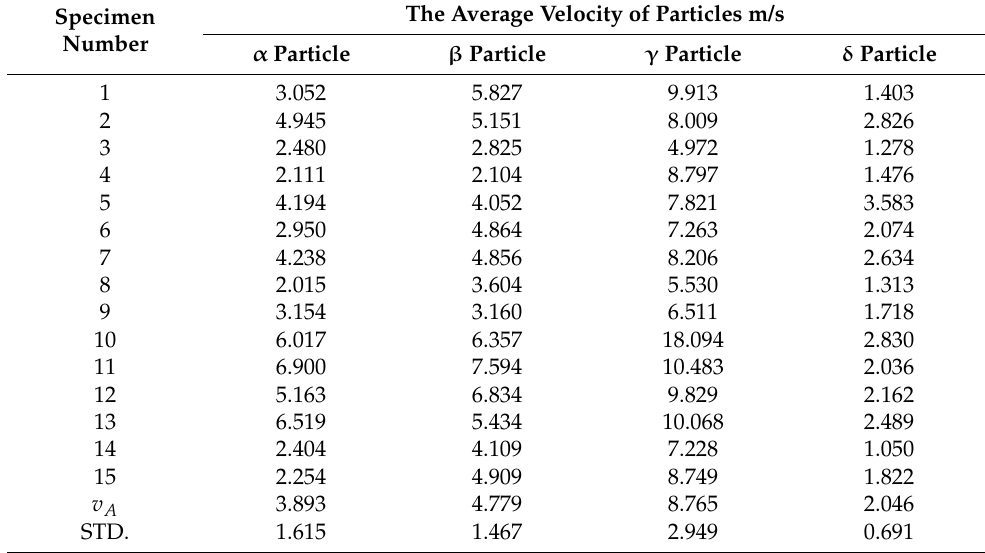
Table 4. Four types of particle velocities in different specimens.